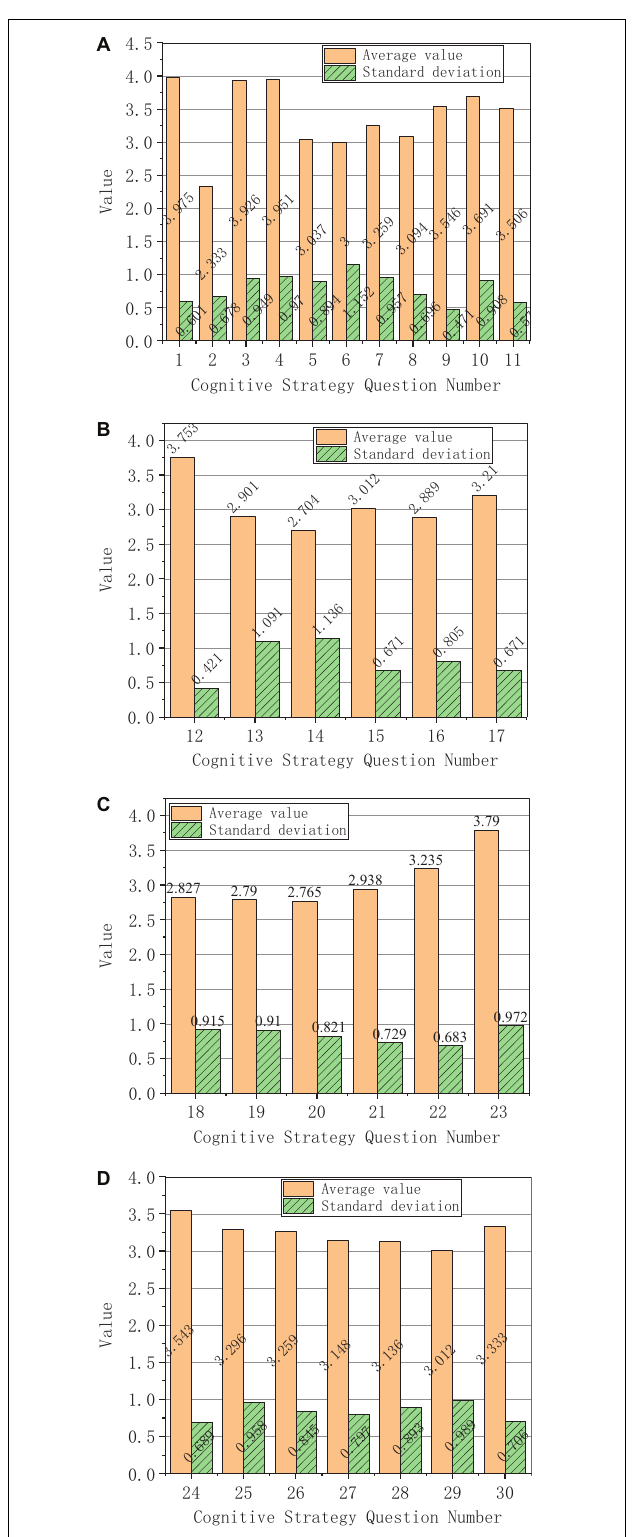
FIGURE 4 | Results of the specific use of learning strategies. (A) Cognitive strategies. (B) Make-up strategies. (C) Metacognitive strategies. (D) Emotional strategies.